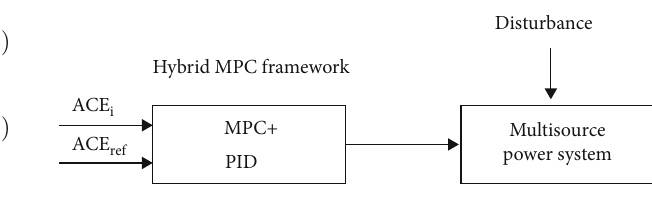
Figure 2: Block diagram of hybrid MPC for